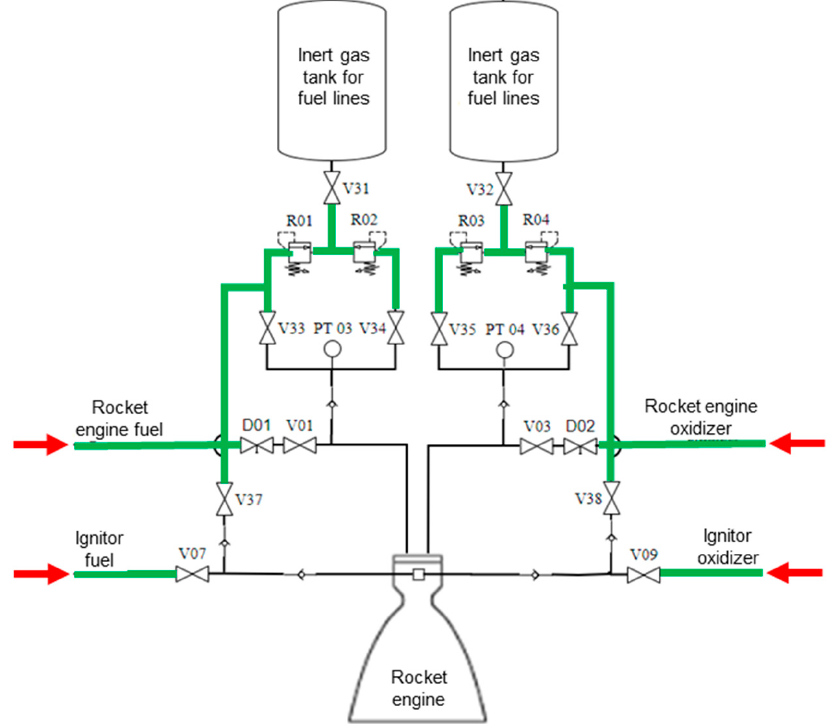
Figure 21. Algorithm’s seventh step diagram.